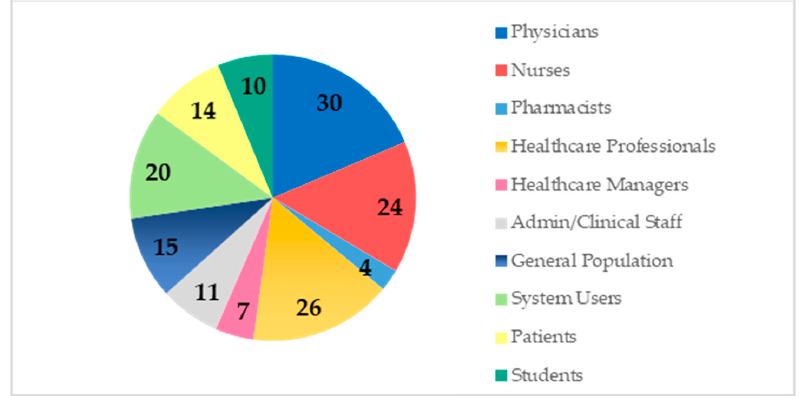
Figure 6. Distribution of studies in terms of participants.